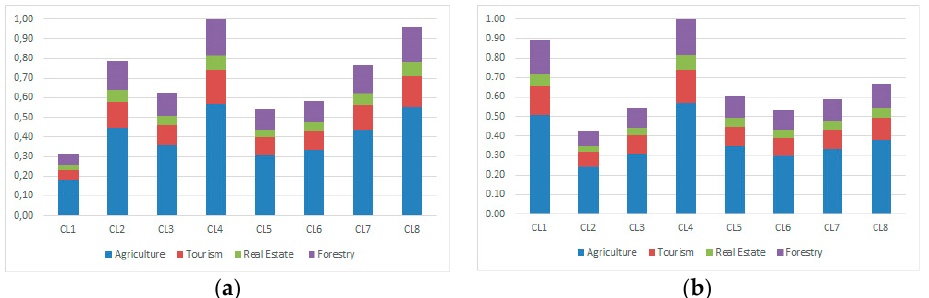
Figure 3. Landscape Economic Attractiveness index (LEA) (a) and Specific Landscape Economic Attractiveness (SLEA) (b) for the MAI landscape.